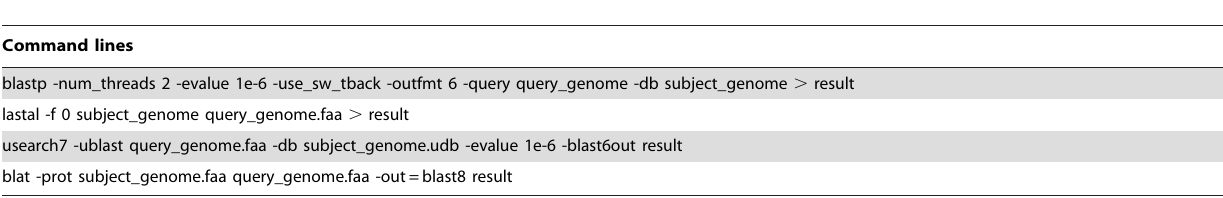
Table 1. Command lines used to run each genome to genome comparison.